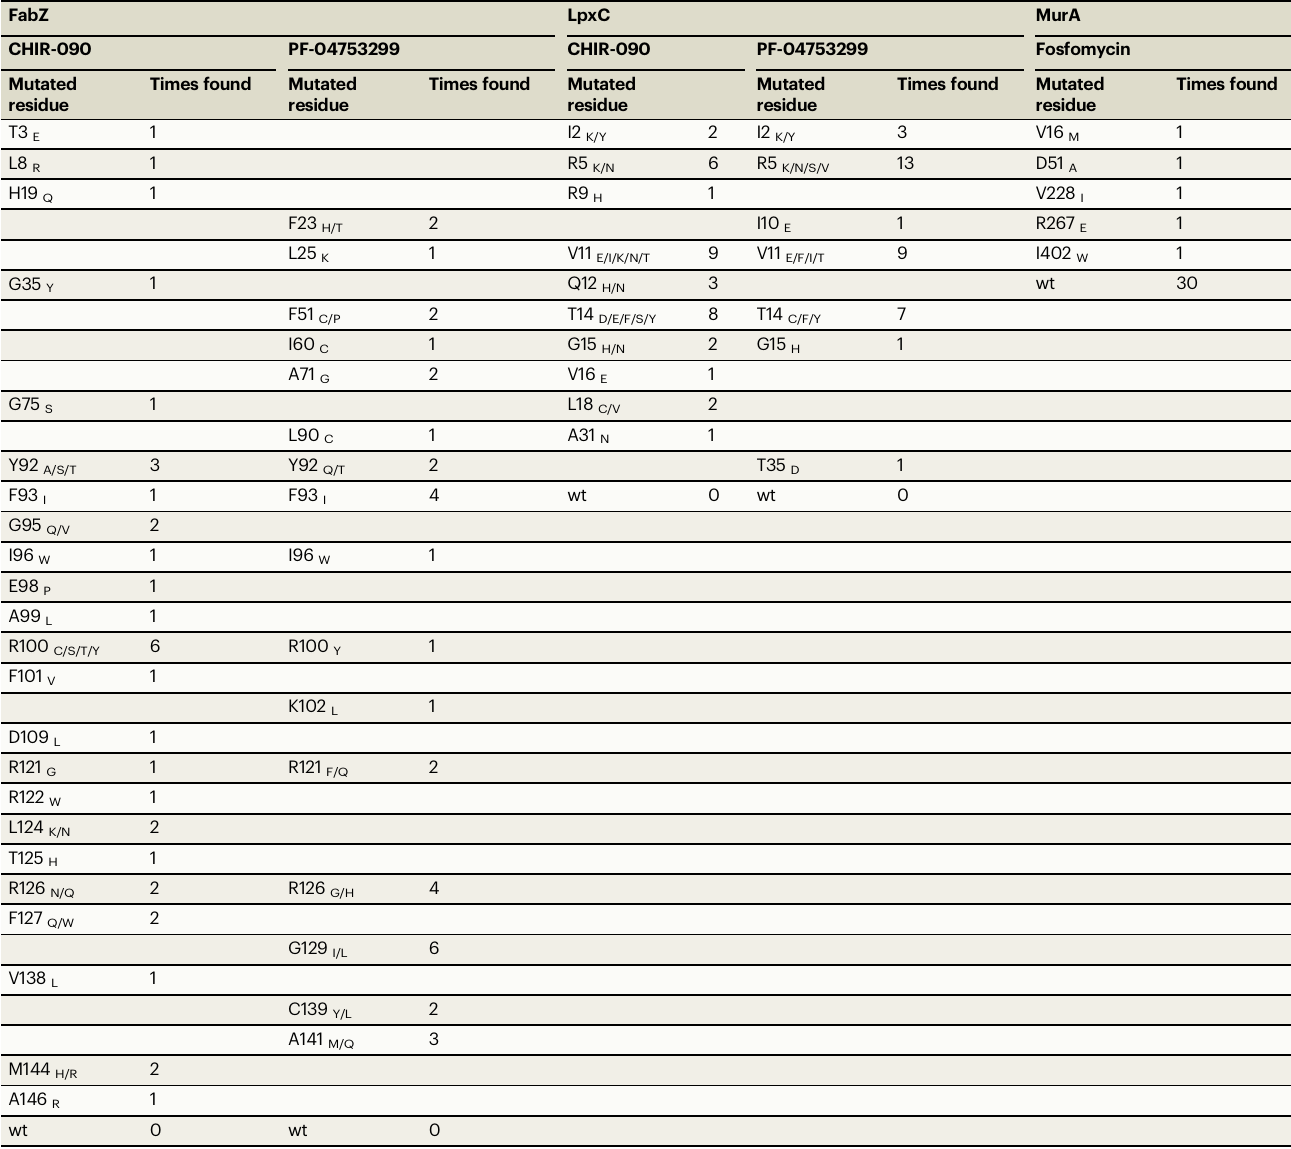
Table 2 | Library variants that are resistant to CHIR-090, PF-04753299 or